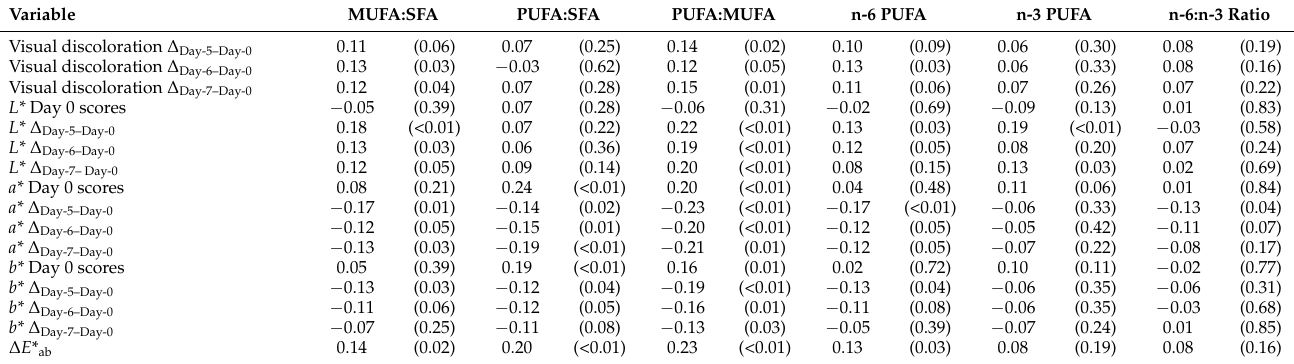
Figure 3. Prediction of visual discoloration rate ( ∆ Day-7–Day-0 ) using the lipid percentage of ground beef as the independent variable ( A ); prediction of change in instrumental L * ( ∆ Day-7–Day-0 ) using lipid percentage of ground beef as the independent variable ( B ); prediction of change in instrumental a * ( ∆ Day-7–Day-0 ) using lipid percentage of ground beef as the independent variable ( C ); prediction of change in instrumental b * ( ∆ Day-7–Day-0 ) using lipid percentage of ground beef as the independent variable ( D ); prediction of ∆ E* ab using lipid percentage of ground beef as the independent variable ( E ); prediction of lipid oxidation rate (TBARS ∆ Day-7–Day-0 ) using lipid percentage of ground beef as the independent variable ( F ). Table 4. Pearson correlation coefficients (r) for fatty acid profile (g/100 g fat tissue) with rate of discoloration during a simulated retail